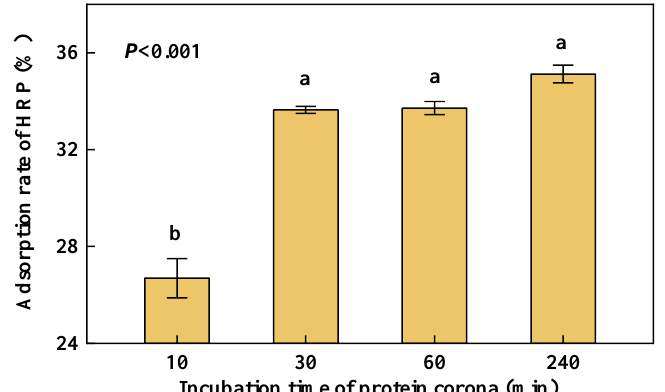
Figure 1. Adsorption rate changes of PS NPs to HRP over time. Dates are means ± SE ( n = 3). Differ- ent letters indicate a significant difference at p < 0.05. Different letters indicate a significant difference at p <